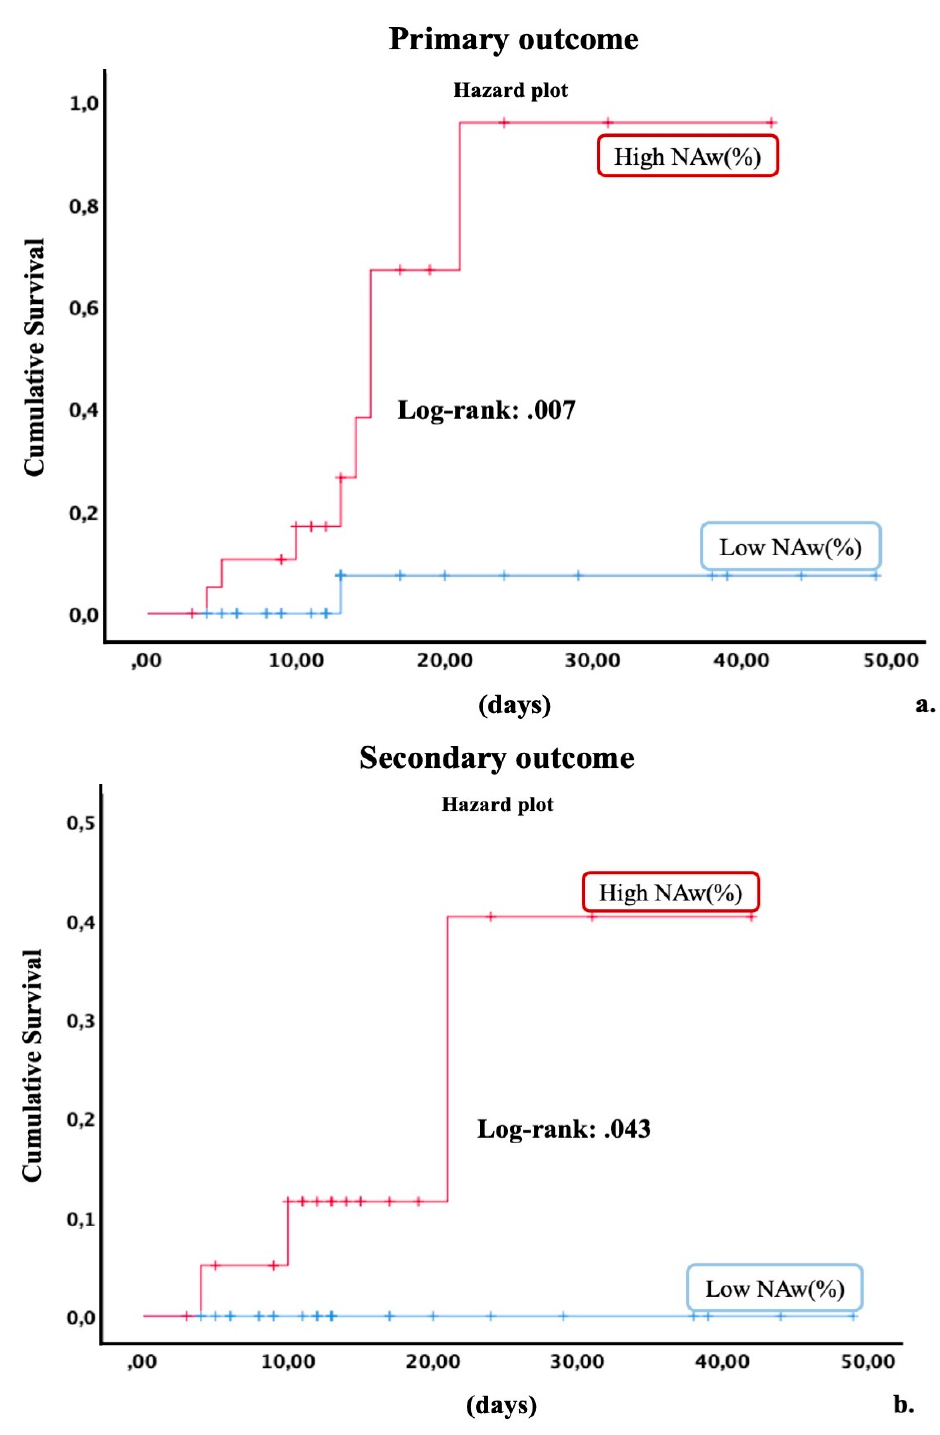
Figure 5. Kaplan–Meier analysis. Cumulative risk for primary ( a ) and secondary ( b ) outcome in patients categorized for median NAw (%) (percentage of non-aerated tissue weight). Table 2. Pearson correlation between quantitative lung CT parameters and significantly different laboratory and respira- tory findings.